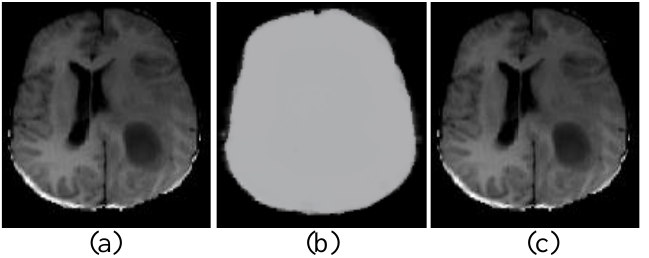
Figure 3. The impact of MR image intensity bias and the outcome of bias field correction. ( a ) before ( b ) the estimated bias field and ( c ) after the N4ITK bias field correction.